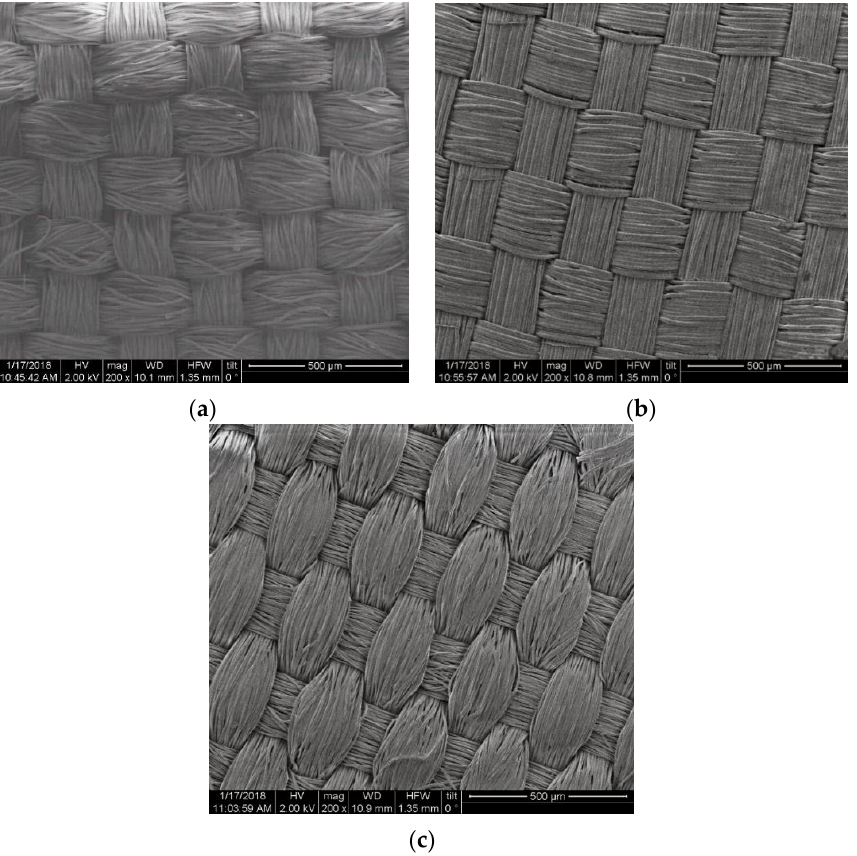
Figure 1. Top down SEM images of the fabrics surface before the plasma micro-nanotexturing: ( a ) Fabric A; ( b ) Fabric B; ( c ) Fabric C.